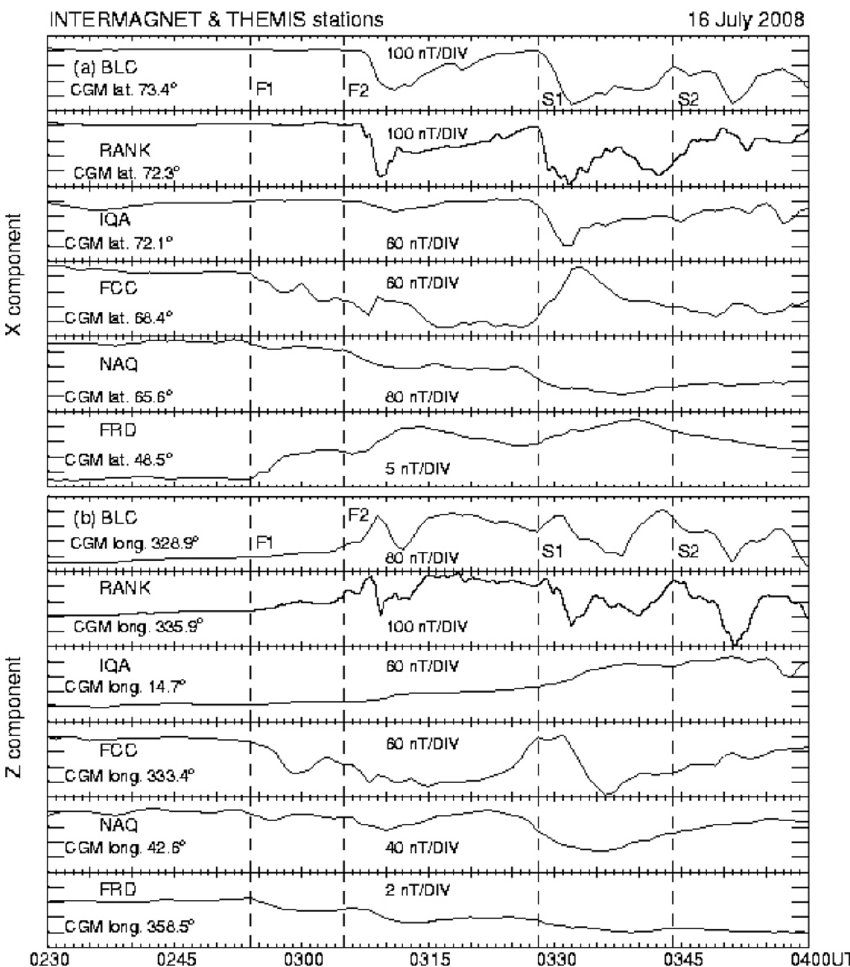
Fig. 7. (a) The X-component at the available INTERMAGNET stations and RANK from 02:30UT to 04:00UT on 16 July 2008. The vertical dashed lines denote ground Pi2 onsets. (b) In the same format as (a) , except for the